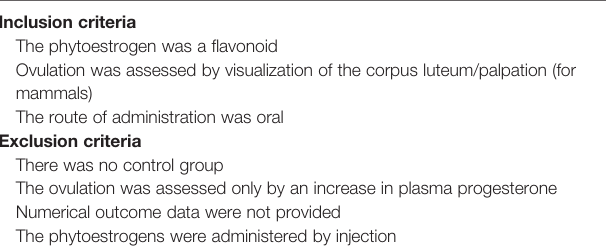
TABLE 1 | Inclusion and exclusion criteria used in the meta-analysis. Inclusion criteria The phytoestrogen was a fl avonoid Ovulation was assessed by visualization of the corpus luteum/palpation (for mammals) The route of administration was oral Exclusion criteria